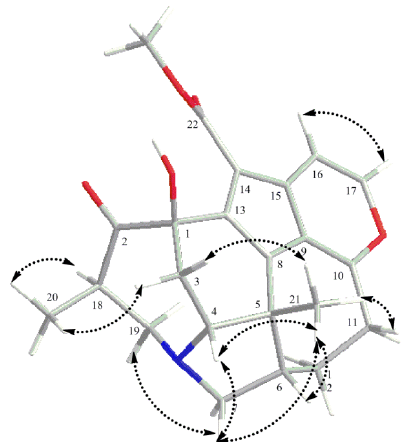
Figure 3. Key NOESY correlations of daphnicyclidin M ( 1